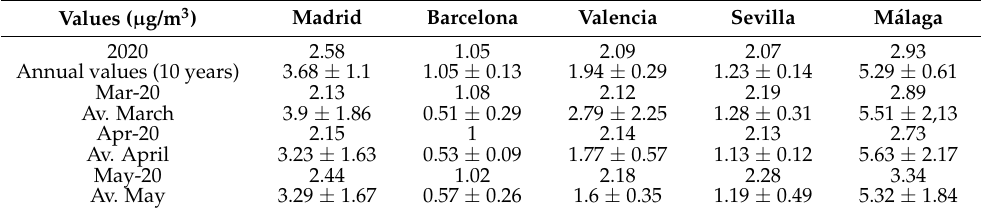
Table 4. Comparison of sulfur dioxide values in 2020 and the 10 years of data series. Av. = average. Values ( µ g/m 3